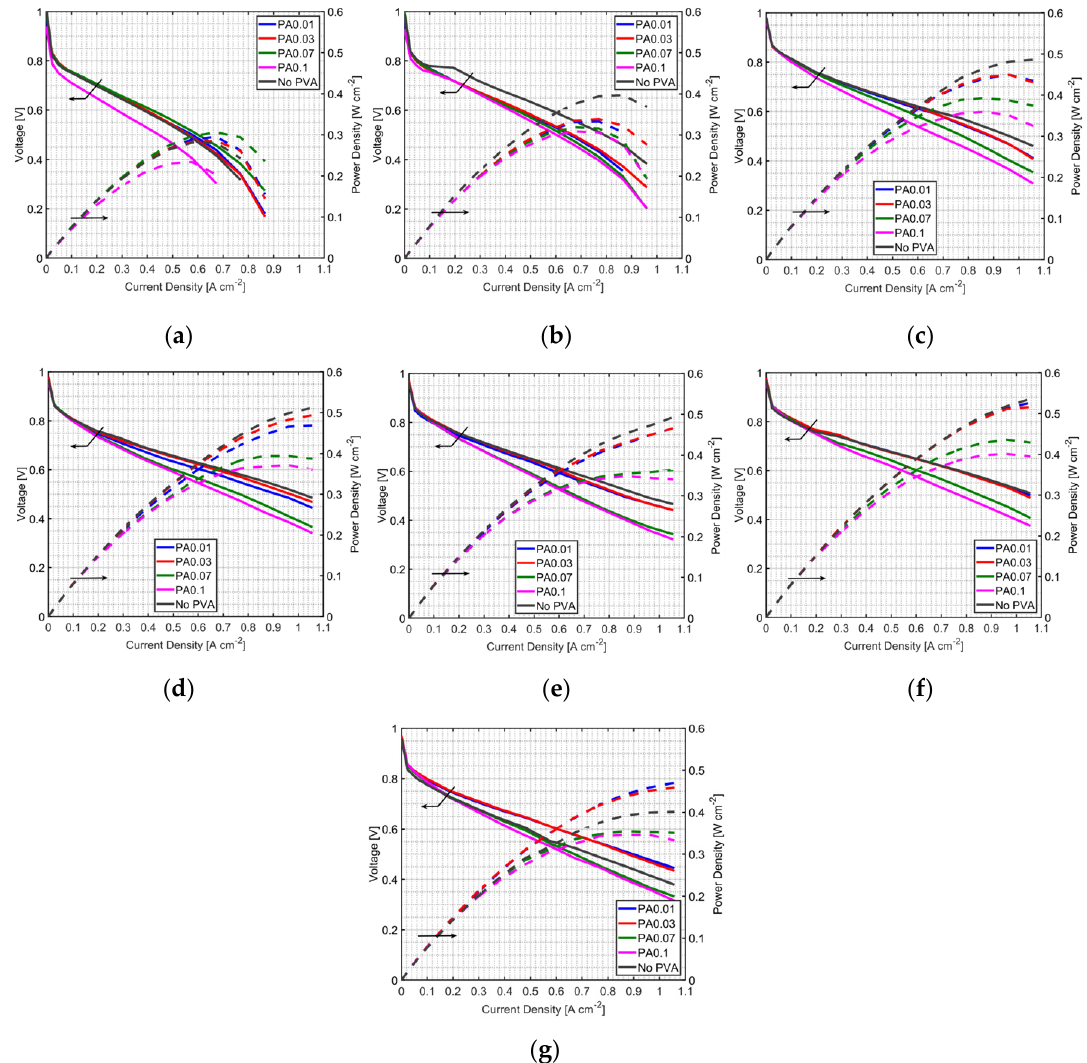
Figure 4. Performances of MEAs prepared with the PA method at a fuel cell temperature of 60 °C and the humidifier temperature of the anode and the cathode at ( a ) 25 °C, ( b ) 30 °C, ( c ) 40 °C, ( d ) 50 °C and ( e ) 60 °C; and at a fuel cell temperature of 70 °C and the humidifier temperature of the anode and the cathode at ( f ) 60 °C and ( g ) 70 °C.